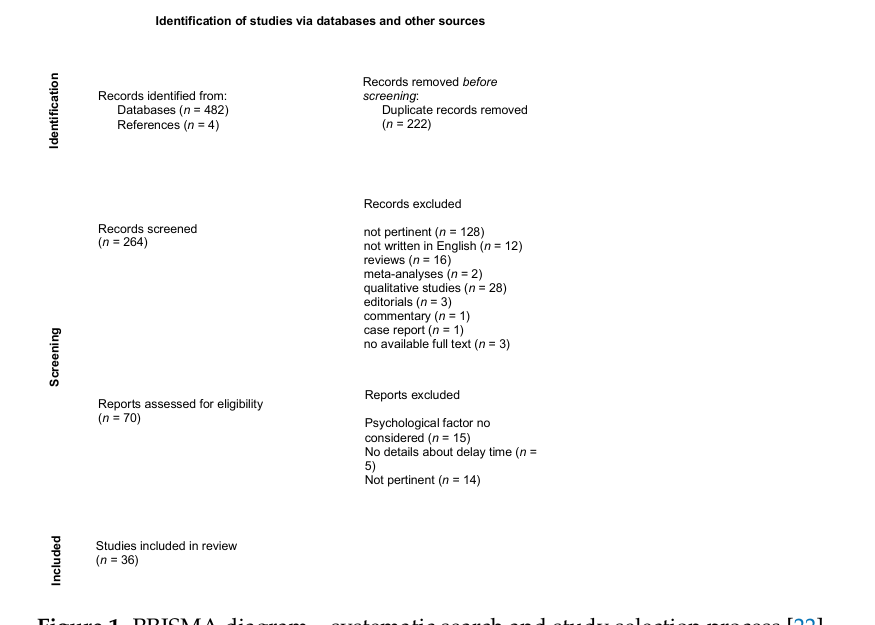
Figure 1. PRISMA diagram—systematic search and study selection process [22].